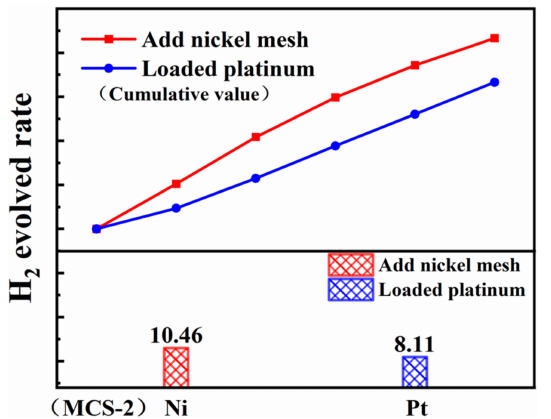
Figure 11. Comparison diagram of hydrogen production through addition of the nickel mesh and loaded